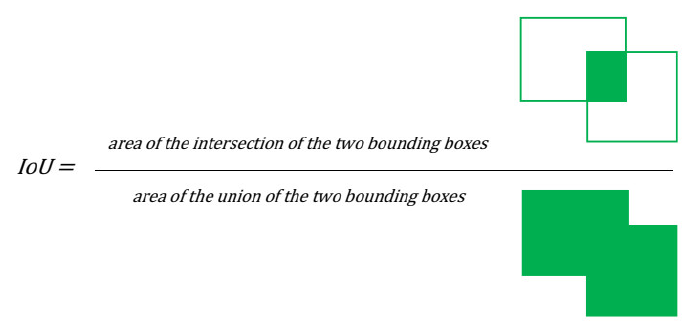
Figure 3. Graphical representation of intersection over union